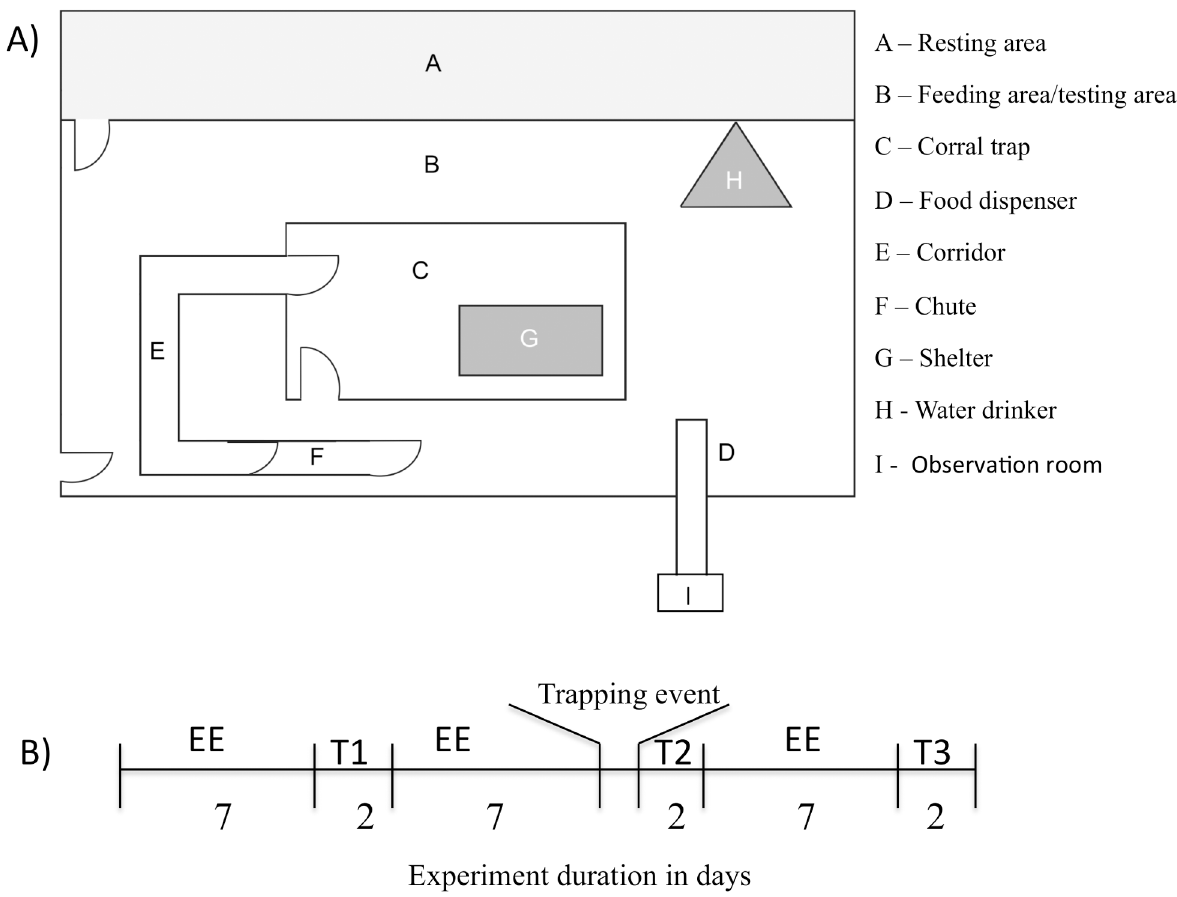
Fig 1. (A) Schematic drawing of the area used and (B) the experiment timeline in days at LABET. Symbols correspondence: EE- environment enrichment; T- test; M-capture, handling